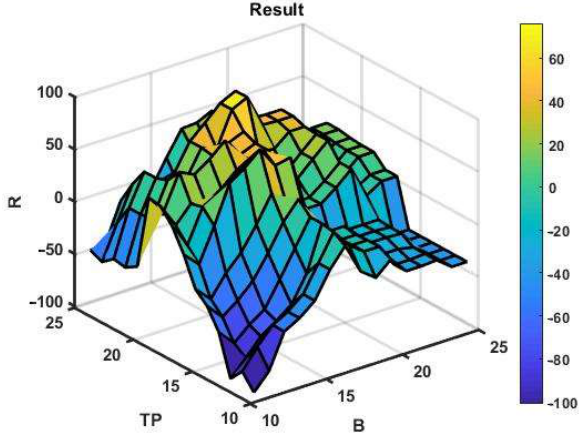
Figure 6. Network approximation of Figure 5.